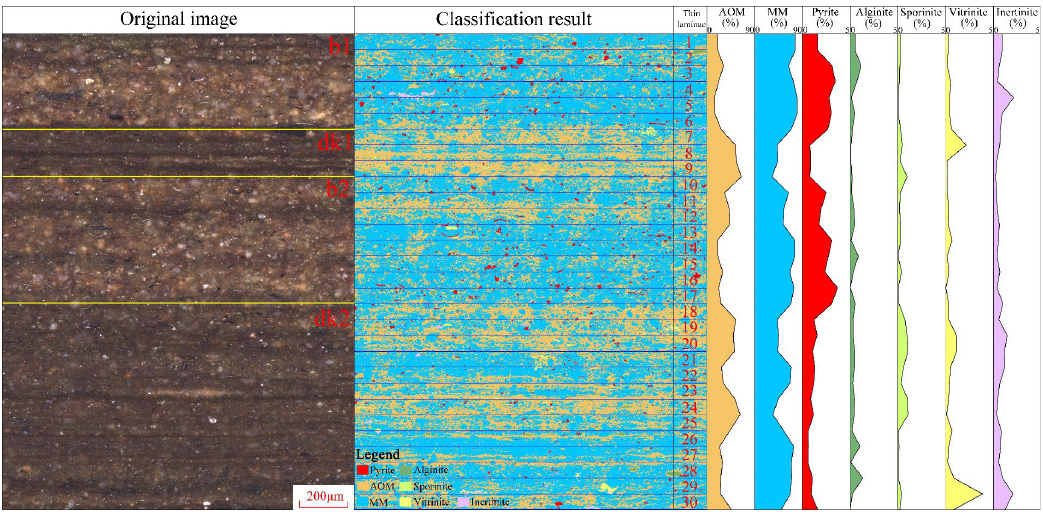
Figure 6. Image classification result and the area percentage content of each classification.